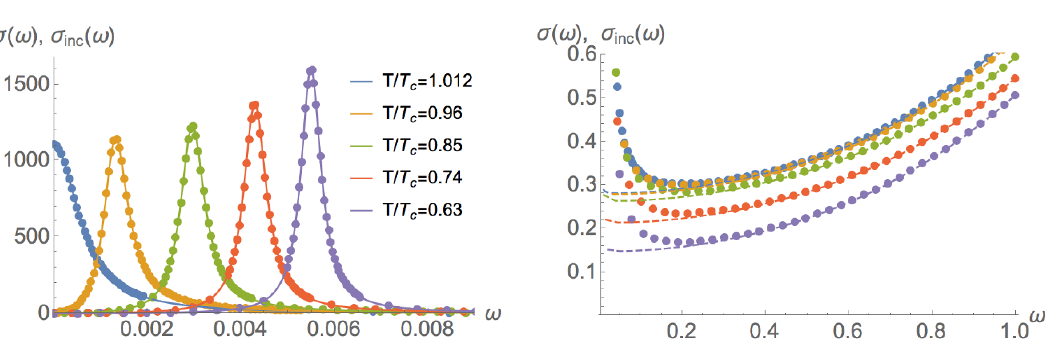
Figure 6 . Four lowest QNMs for the explicit case (2.8) with varying temperature. The green and blue dots show the coherent modes corresponding to (approximate) momentum conservation. These would be the two sound modes in the translationally invariant case, which turn into two di(cid:11)usive modes in presence of momentum relaxation. The red and yellow dots are incoherent, non- hydrodynamic modes. The left panel shows the motion of these modes in the complex plane, the arrows pointing towards lower temperatures. We observe two collisions on the imaginary axis as the temperature is lowered. After the collision the modes acquire a non-zero real part and the coherent modes can no longer be identi(cid:12)ed. We show the imaginary parts of these modes as a function of temperature on the right panel.